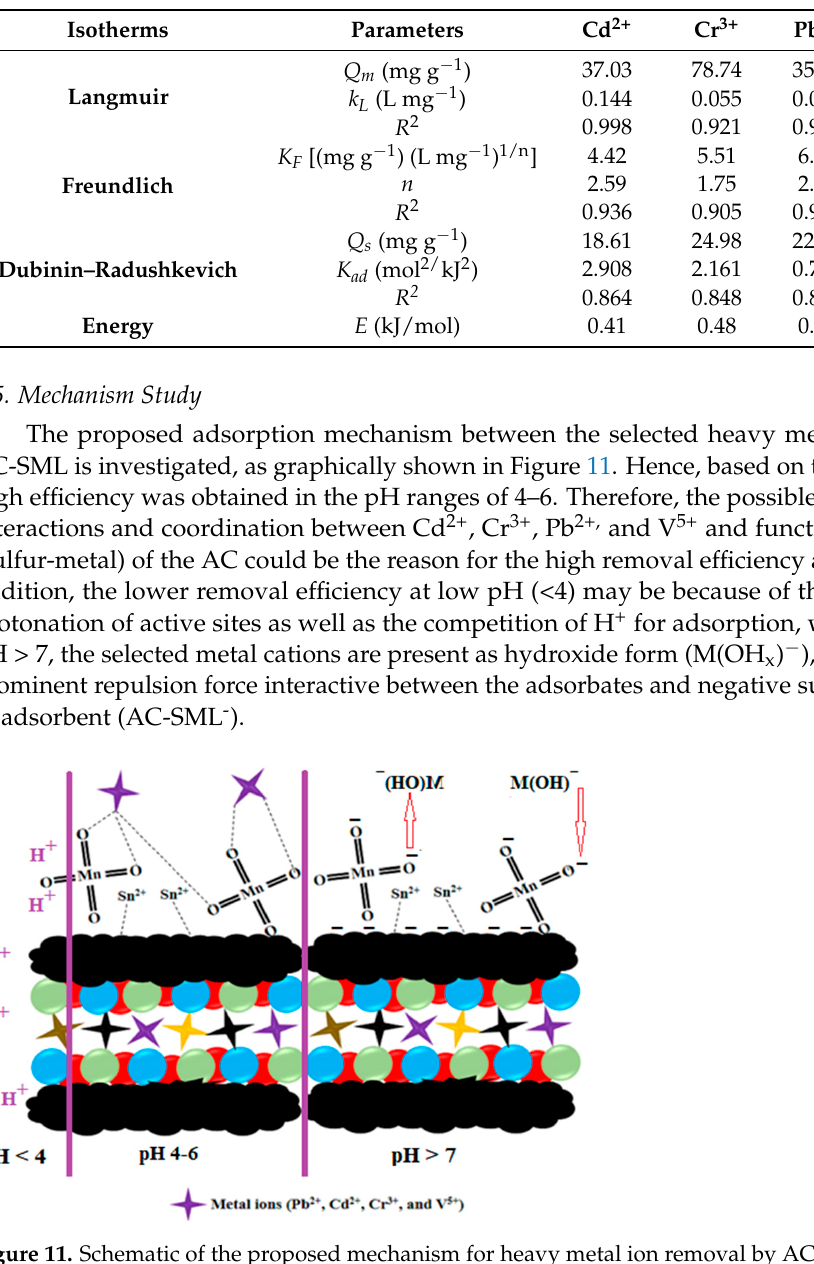
Table 2. Langmuir, Freundlich, DR models and free Energy for adsorption of selected heavy metal ions over AC-SML nanocomposite.